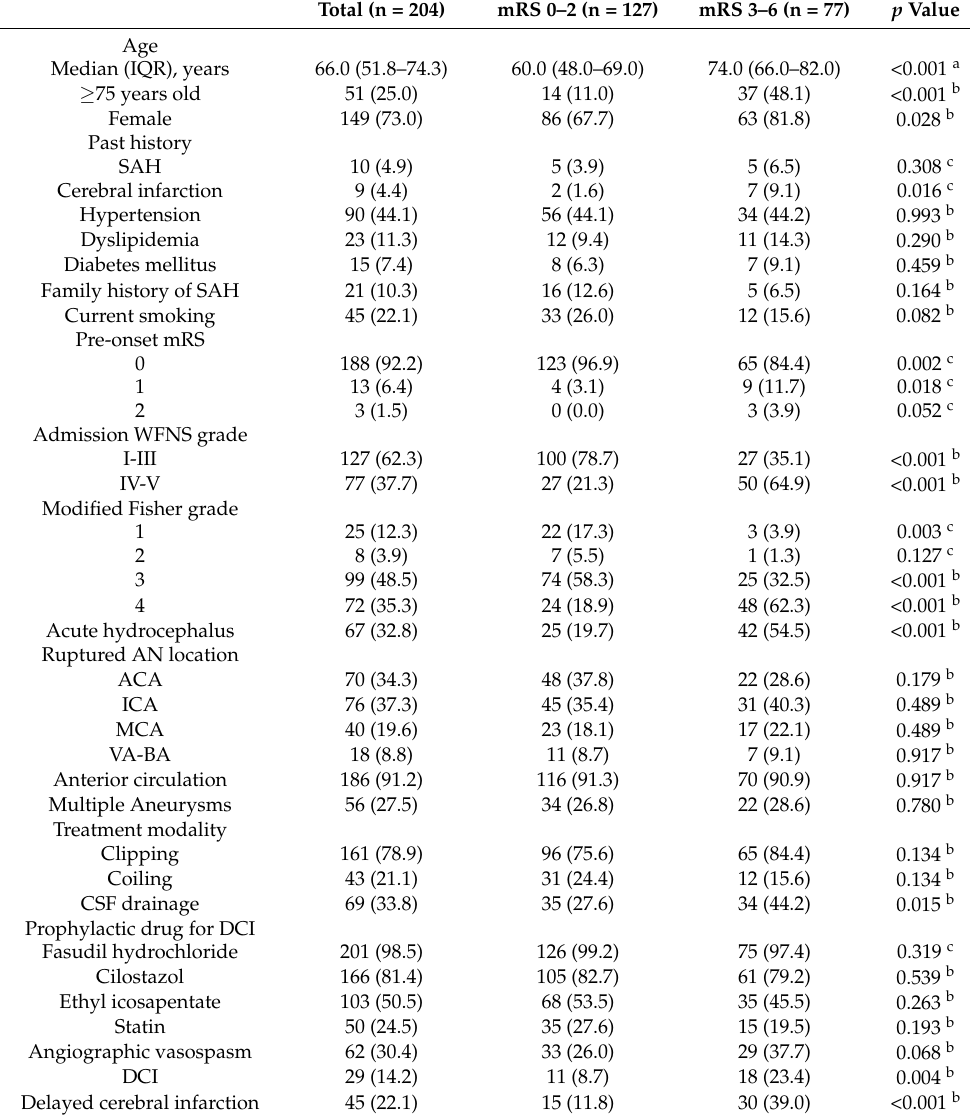
Table 1. Clinical variables related to the 90-day poor outcome or modified Rankin scale (mRS)